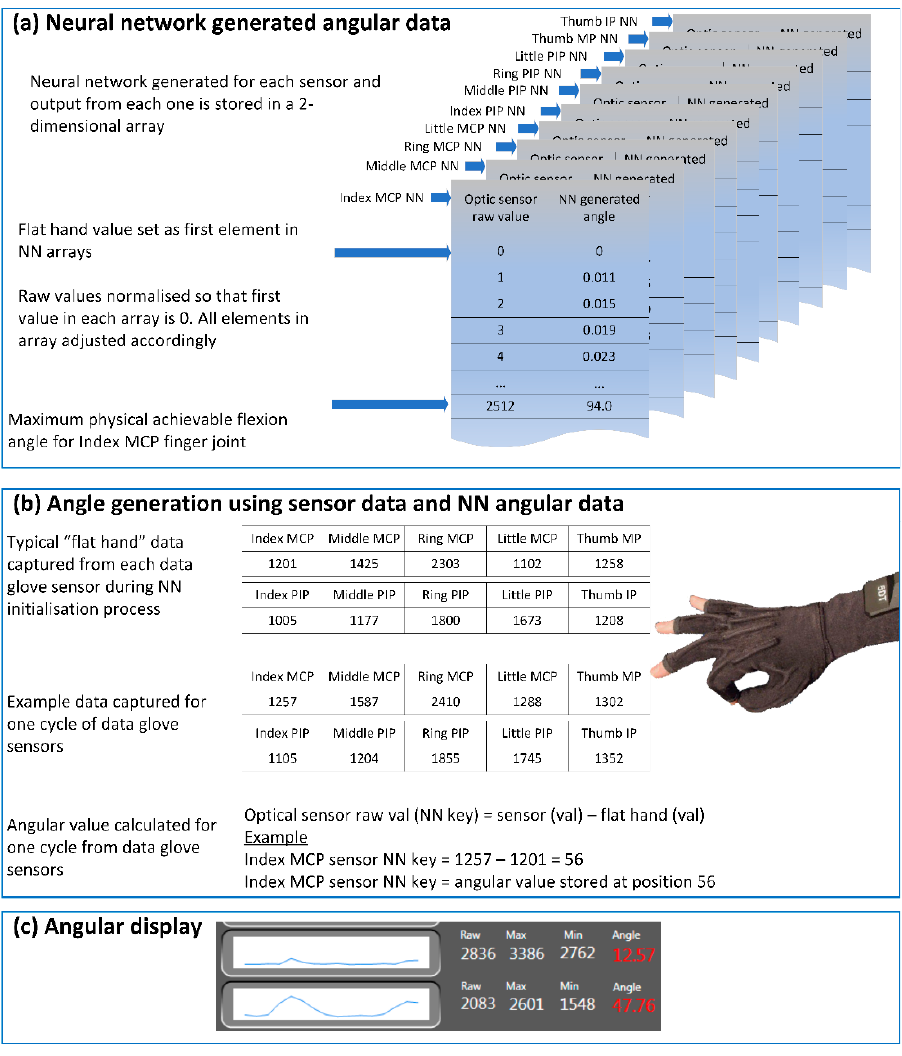
Figure 4. NNs were created for each data glove sensor. Optimum NN for each sensor was used to predict angular values for that sensor. ( a ) Predicted values for each sensor were stored in a 2D array and used for angular calculation. ( b ) Each angle was indexed by subtracting the “flat hand” value for each sensor from the sensor output. Index key indicates array position containing the correct angular reading for a sensors bend angle. ( c ) Angular readings were then displayed using controlling software .